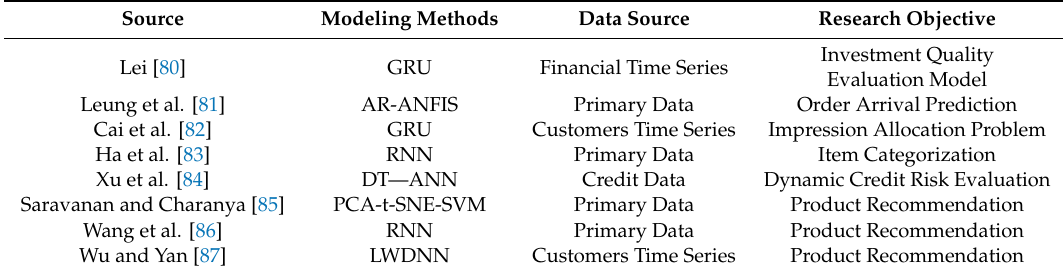
Table 5. Notable machine learning and deep learning methods in